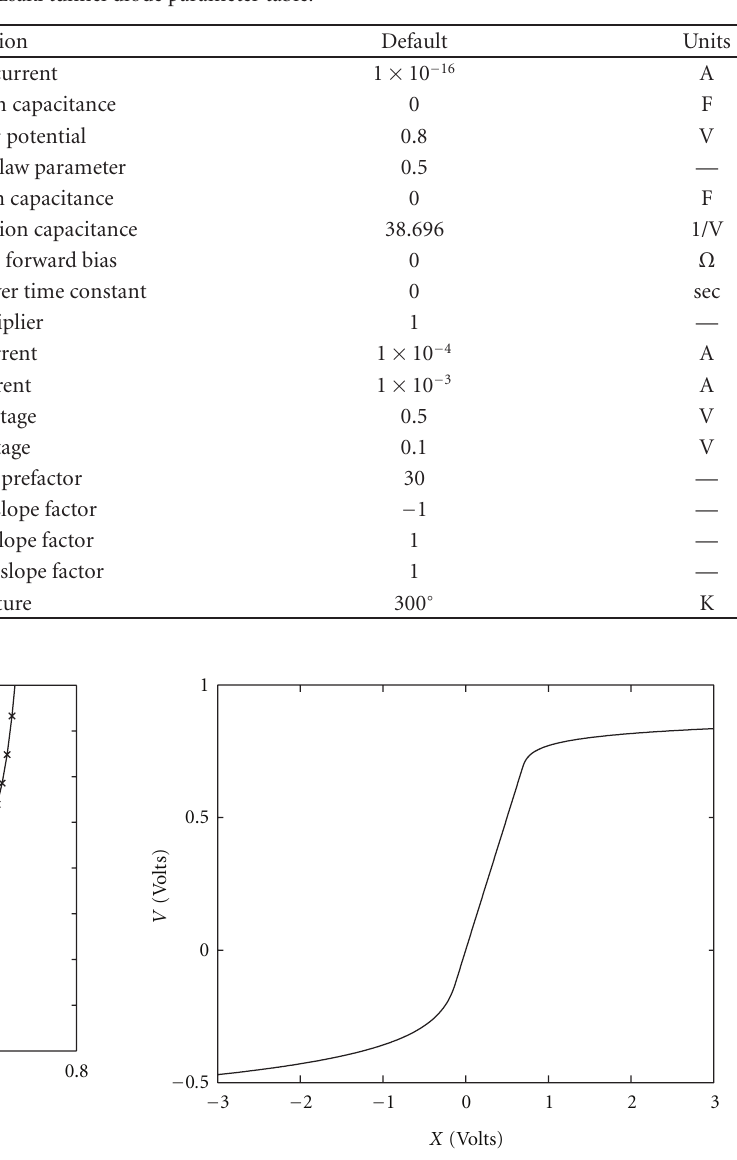
Table 1: Esaki tunnel diode parameter table.